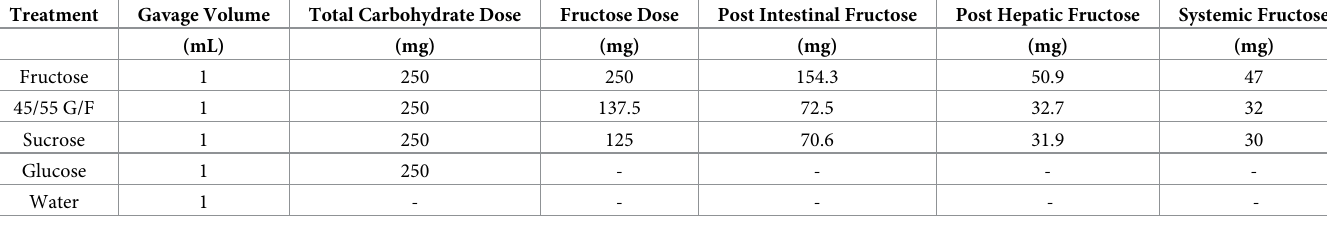
Table 1. Total carbohydrate and fructose dose and estimated fructose amounts after absorption and metabolism.